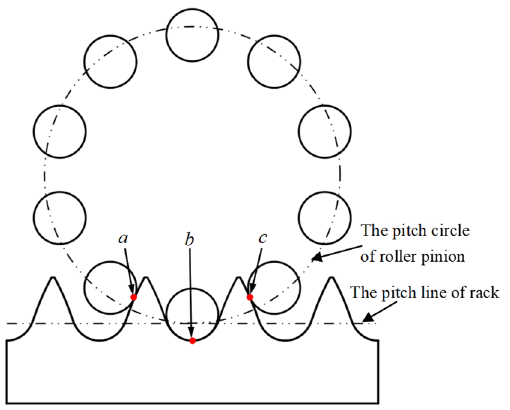
Figure 3. Schematic diagram of meshing of trochoidal roller pinion rack.